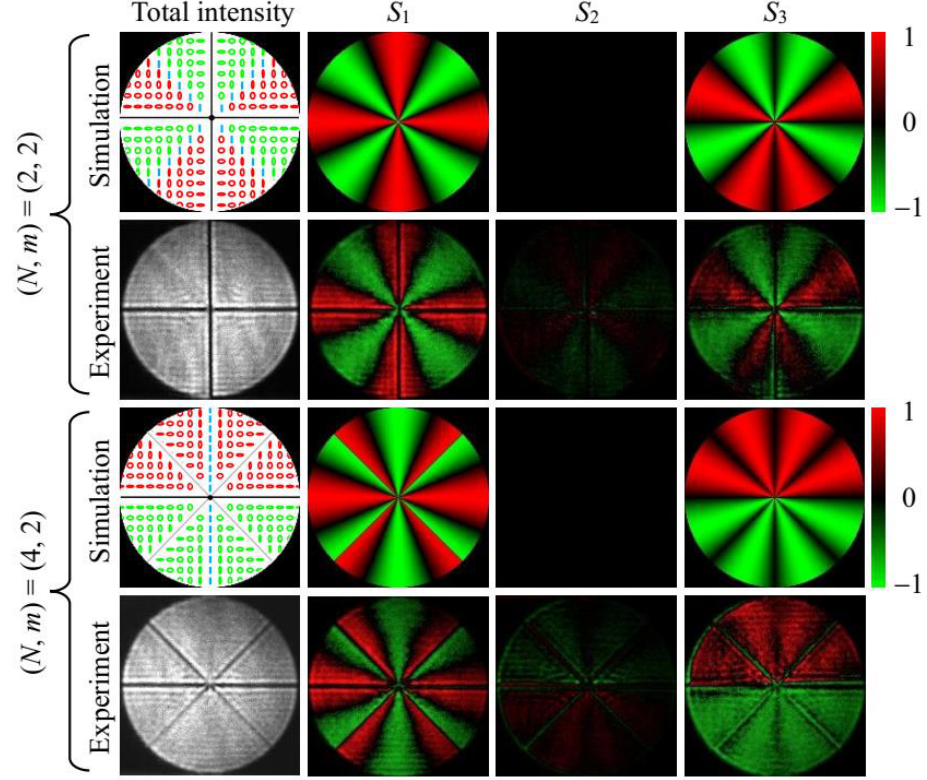
Figure 2. Simulated and measured SM-HP-VOF. The first and second rows correspond to the case when ( N , m ) = (2, 2) , and the third and fourth rows correspond to the case when ( N , m ) = (4, 2) . The first and third rows show the simulated results of the SM-HP-VOF, and the second and fourth rows show the corresponding experimental results. The first column shows the polarization states and the experimental total intensity patterns. The blue, red, and green polarizations represent linear, right- and left-handed elliptic (circular) polarizations, respectively. Stokes parameters S 1 , S 2 , and S 3 are given in the second to fourth columns, respectively.